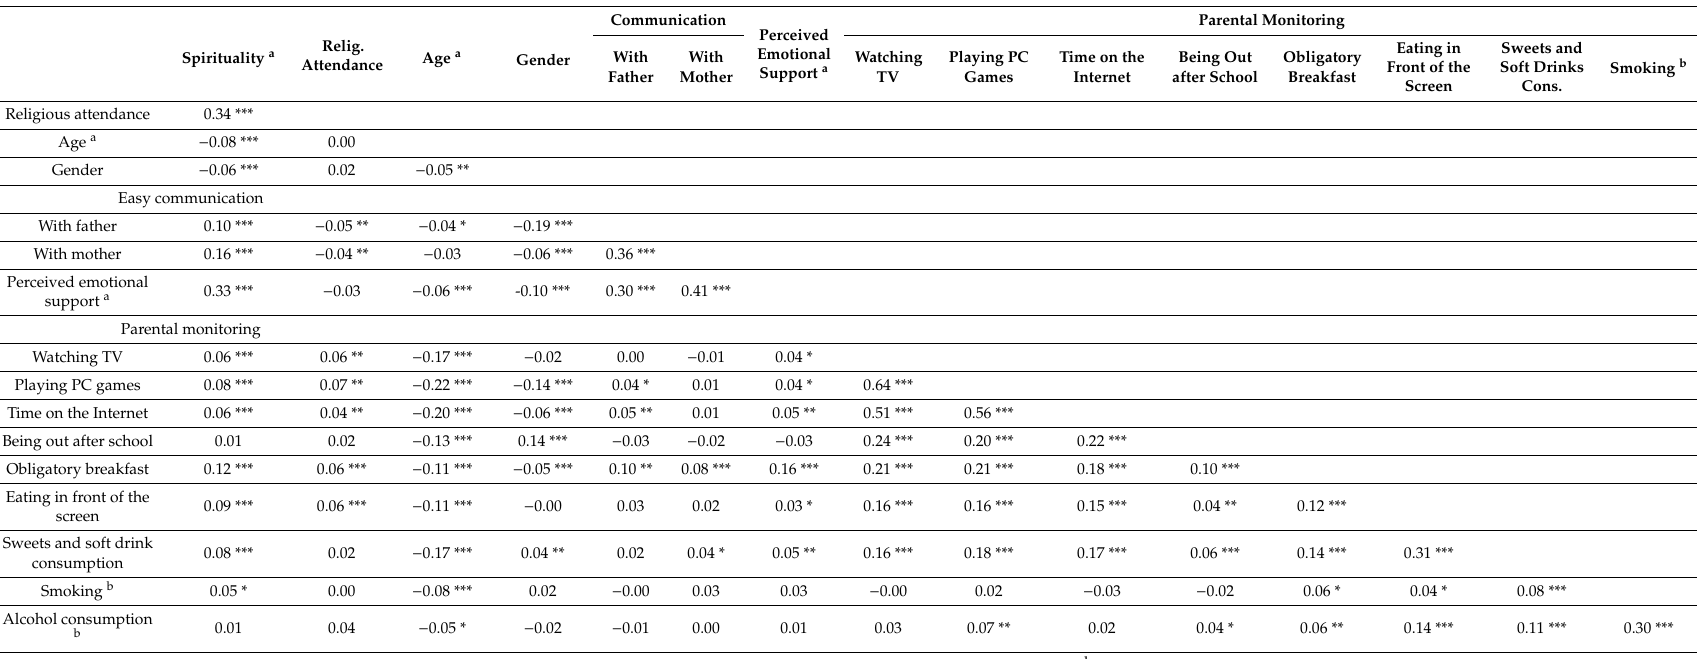
Table 2. Correlations of the variables in the